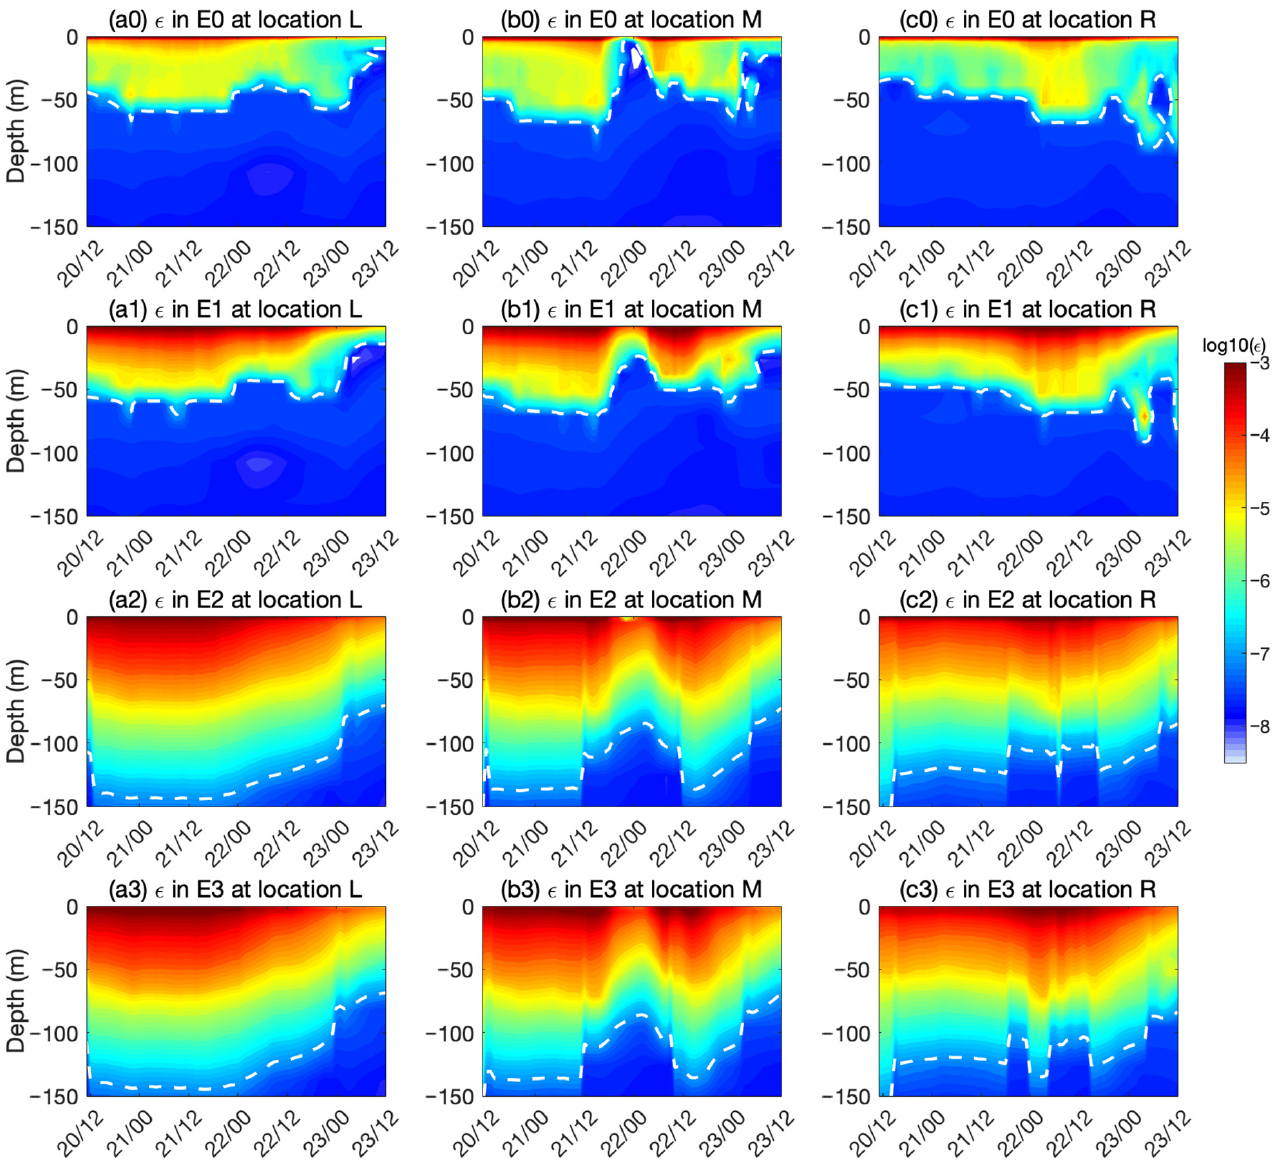
Figure 13. TKE dissipation rate ε (m 2 /s 3 ) among different experiments at locations of L, M, and R (indicated in Figure 10c). The white dashed lines represent the isoline of 1 × 10 − 7 m 2 /s 3 .